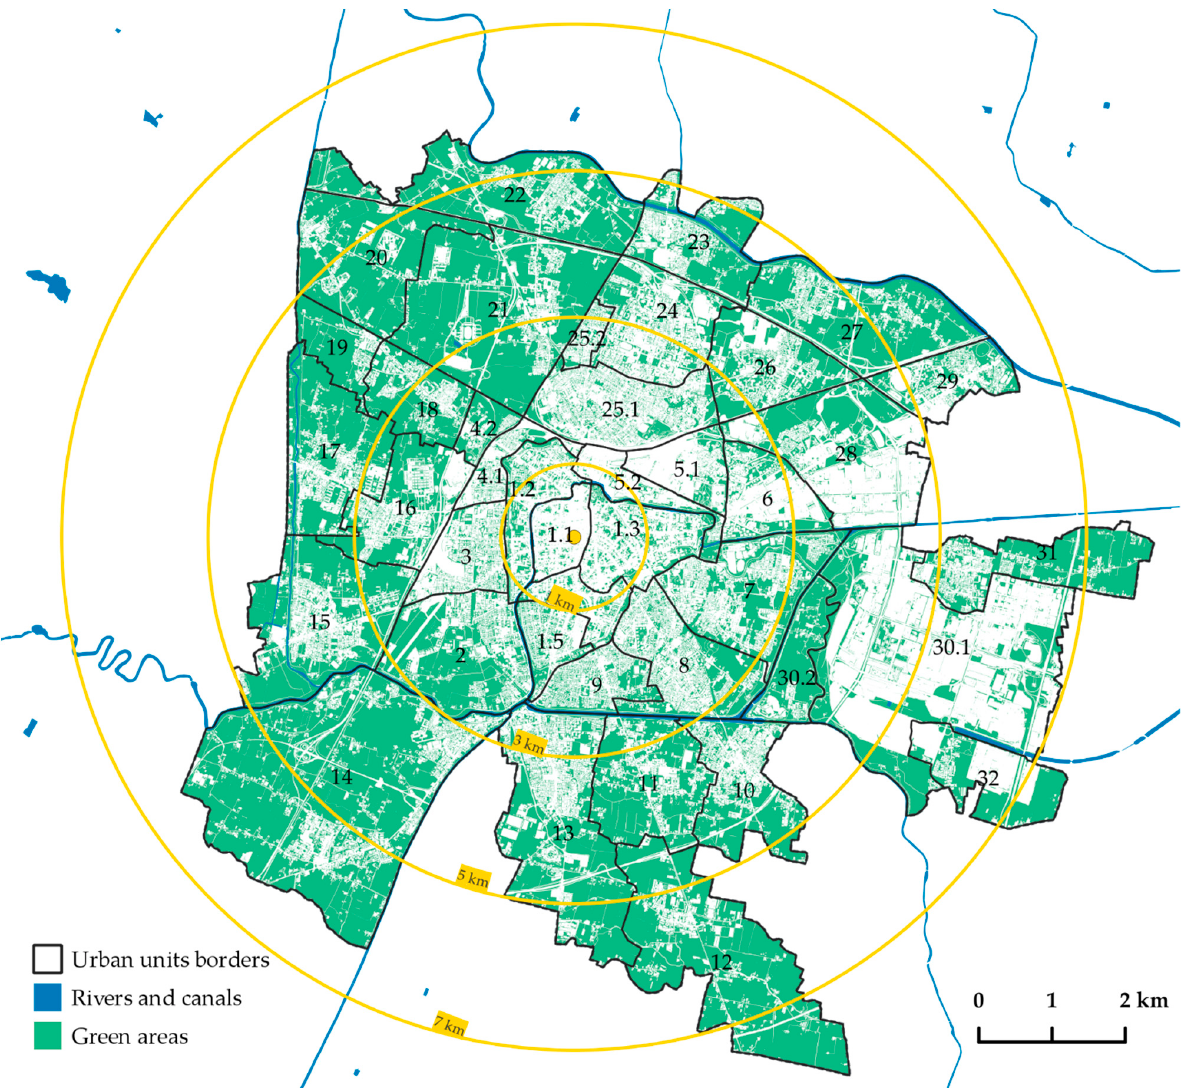
Figure 6. Spatial distribution of all urban green spaces (for definition UGS see paragraph 1.3) in the city of Padua, divided by urban units (municipal codes; see Table 11 for corresponding urban unit names). In yellow are the distances at 1 km, 3 km, 5 km, and 7 km from the city centre (yellow dot).